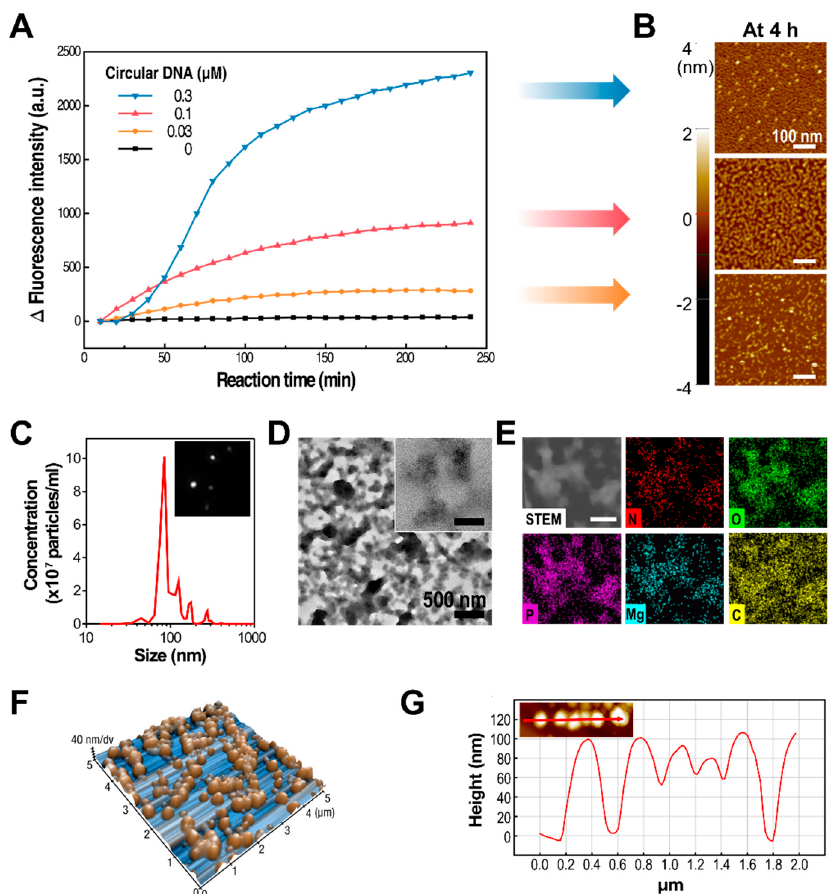
Figure 2. ( A , B ) Real-time analysis of RNA generation during the RCT reaction with various concentrations of circular DNAs ( A ), and the corresponding atomic force microscopy (AFM) images of the RCT products at 4 h ( B ). ( C ) Nanoparticle tracking analysis of shRNA nanoparticles (shRNA-NPs), revealing their size distribution and their concentrations. Inset image was captured from Supplementary Video 1, showing the scattered lights from nanoparticles exhibiting Brownian motion in solution. ( D , E ) Transmission electron microscopy (TEM) image and high-resolution TEM image (inset) of shRNA-NPs ( D , inset scale bar: 100 nm), and TEM-based energy dispersion X-ray (EDX) mapping result ( E , inset scale bar: 400 nm), showing the atomic compositions of the NPs. ( F , G ) AFM image of shRNA-NPs reconstructed in 3D ( F ), and cross-sectional analysis of the AFM image along the red line shown in the inset image ( G ).